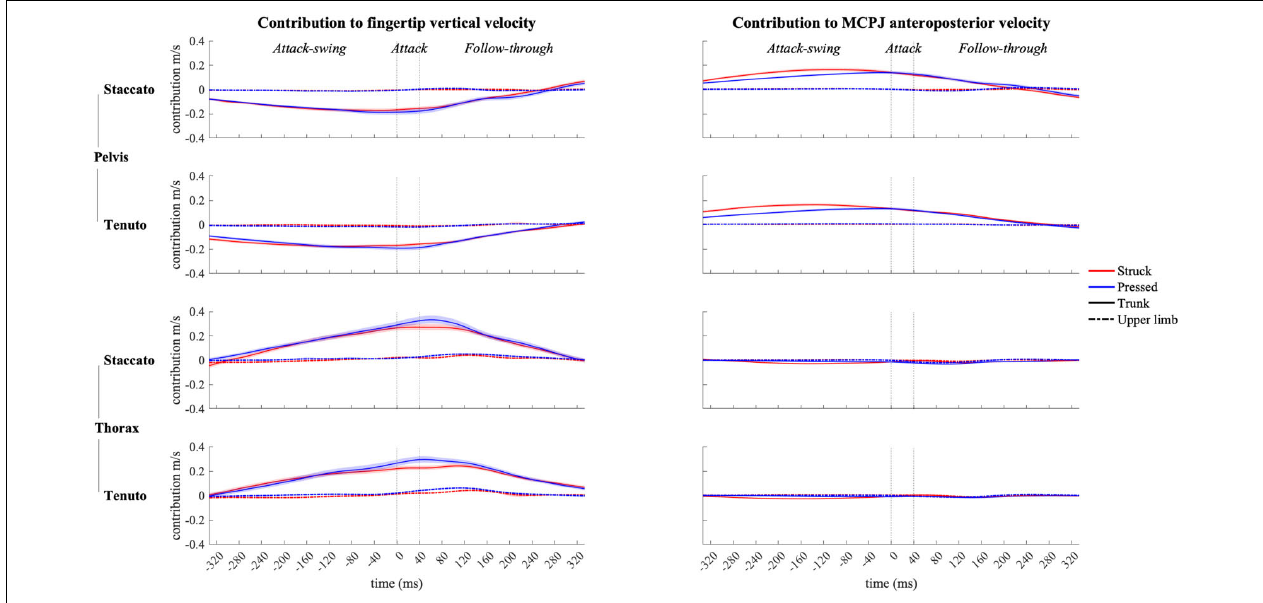
FIGURE 8 | Mean values (solid and dash-dotted lines) and 95% bootstrap confidence interval (shaded areas) of pelvic joint and thoracic joint angular contribution to endpoint velocities during the three phases of the keystroke. Negative/positive values indicate contributions to downward/upward fingertip velocities and to backward/forward metacarpophalangeal joint (MCPJ) velocities.